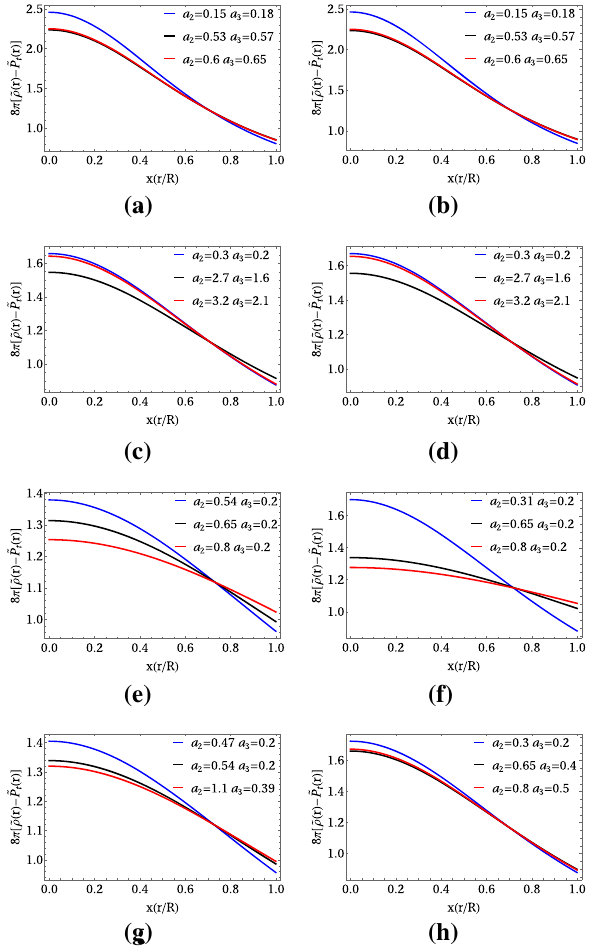
Fig. 8 ˜ ρ( r ) − ˜ P t ( r ) as a function of r for Model 1: ( a ) u = 0.19803, ( b ) u = 0.2035, Model 2: ( c ) u = 0.19803, ( d ) u = 0.2035, Model 3: ( e ) u = 0.19803, ( f ) u = 0.2035, Model 4: ( g ) u = 0.19803, ( h ) u = 0.2035